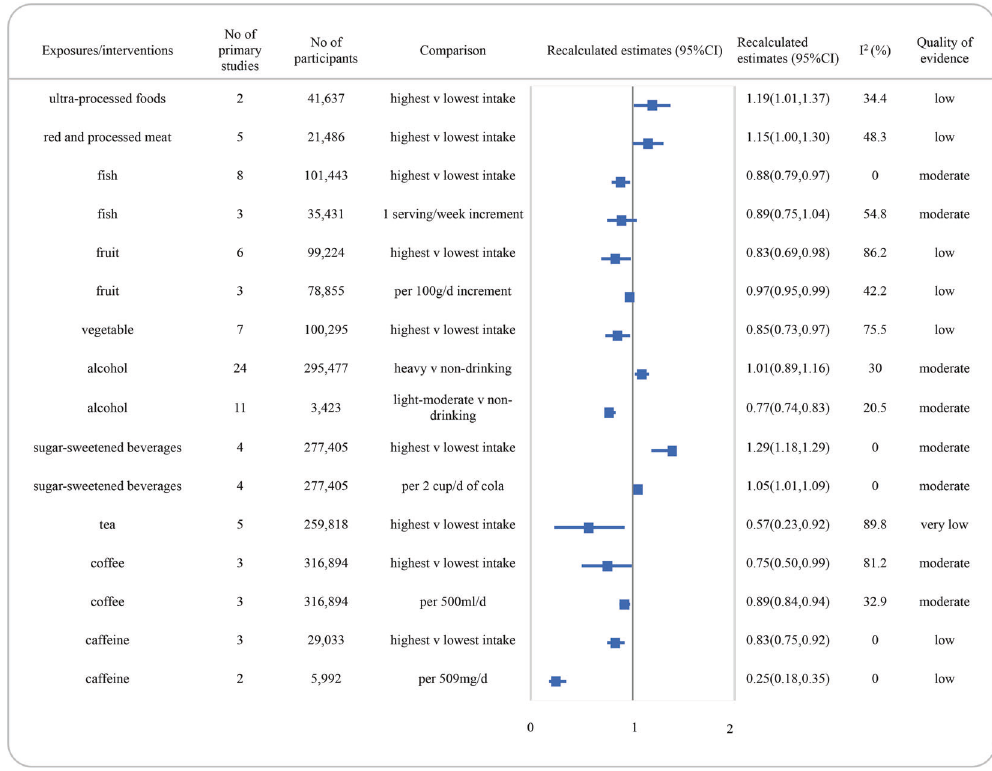
Fig. 3 Summary estimates with 95% con fi dence intervals and quality of evidence for the associations between food and beverages and the risk of depression. SSBs sugar-sweetened beverages, CI con fi dence